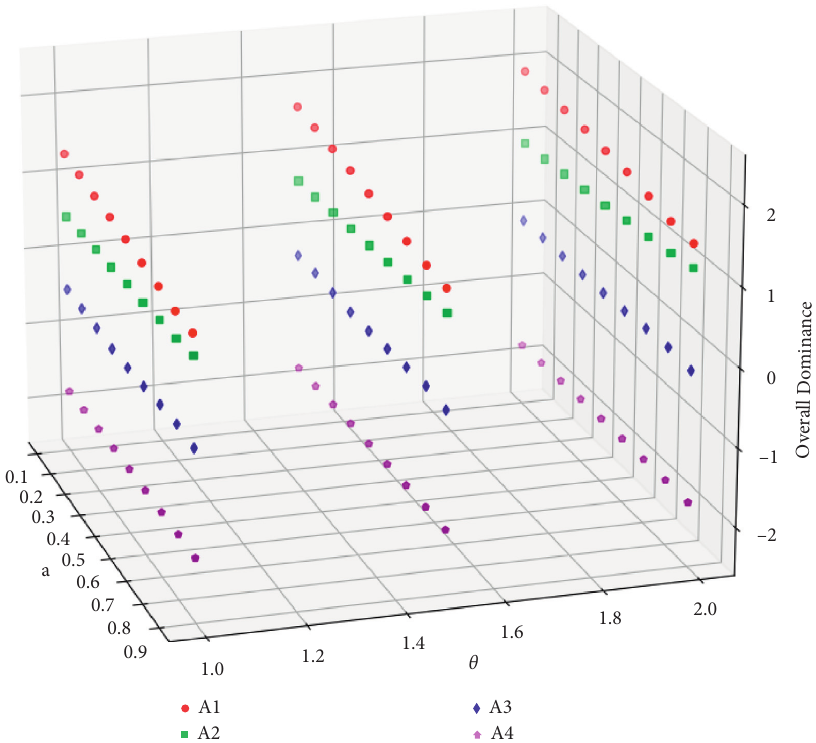
Figure 6: The pictorial expressions of the dominance values with different values of α and θ in case of q � 3.